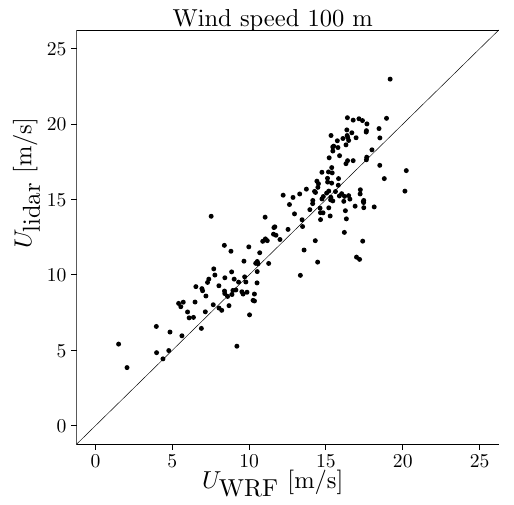
Figure 2. Time series of the wind speed at 100m height from the WRF model simulations at the Høvsøre mast (red) and the mea- surements with the wind lidar (blue) for the period 15–31 Septem- ber 2010. The lidar measurements are filtered with a Carrier to Noise Ratio (CNR) larger than − 22dB. The lidar worked well dur- ing the whole period, the missing measurements are caused by the filtering.